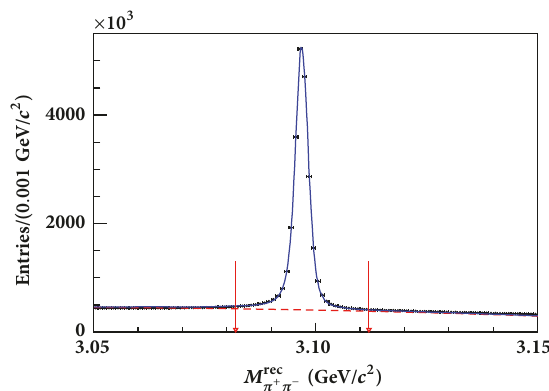
Figure 1: The 𝑀 rec 𝜋 + 𝜋 − spectra of candidate events from inclusive 𝜓(3686) MC sample (the dots with error bars). The solid line shows the best fit to the spectra and the dashed line shows the background. The 𝐽/𝜓 signal region is shown between the two